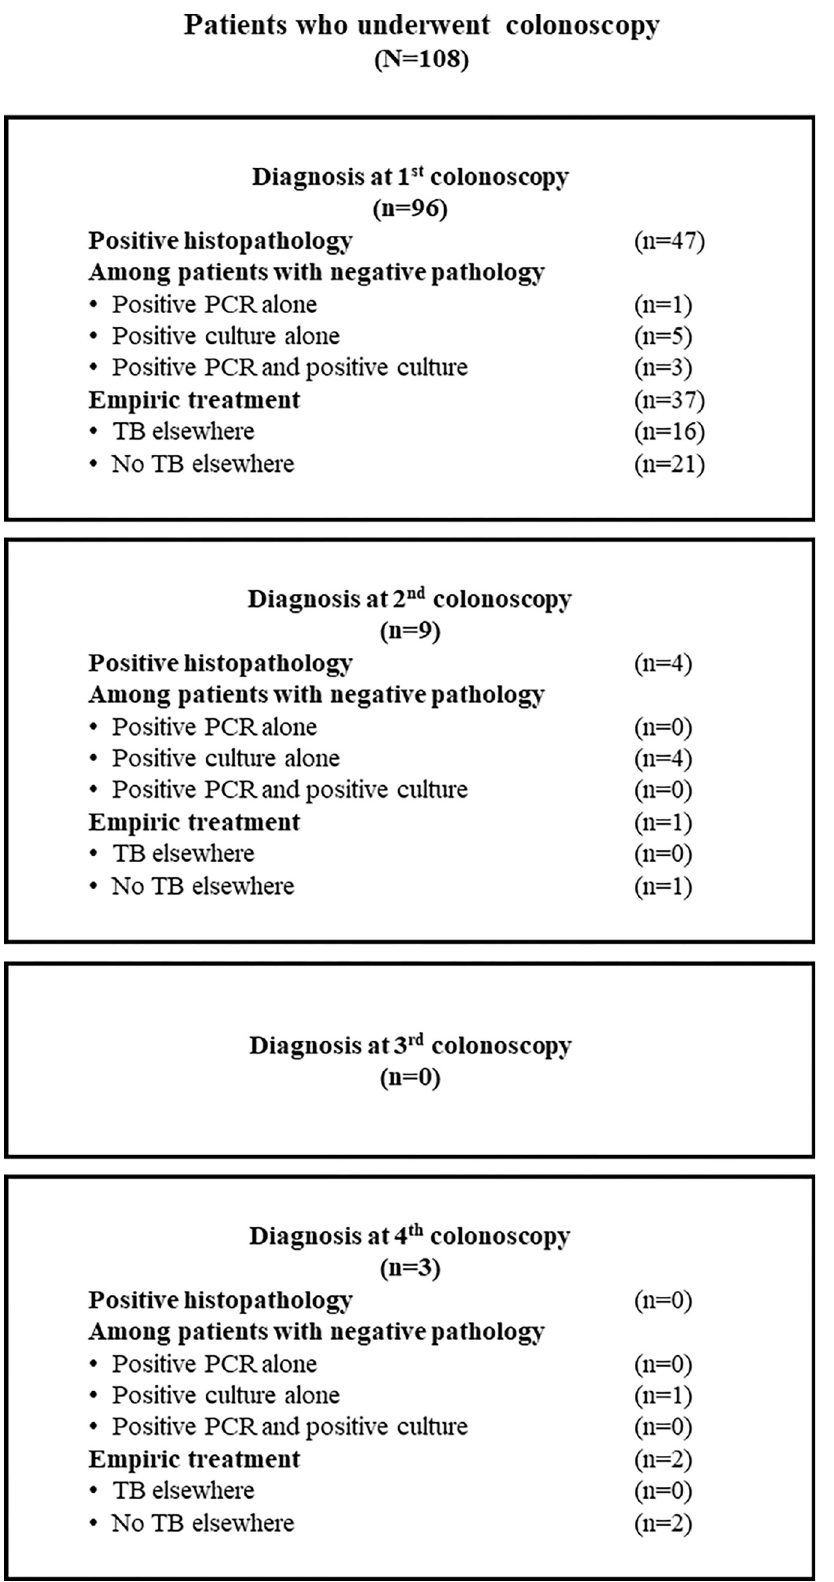
Fig 3. Diagnostic methods in 108 patients undergoing